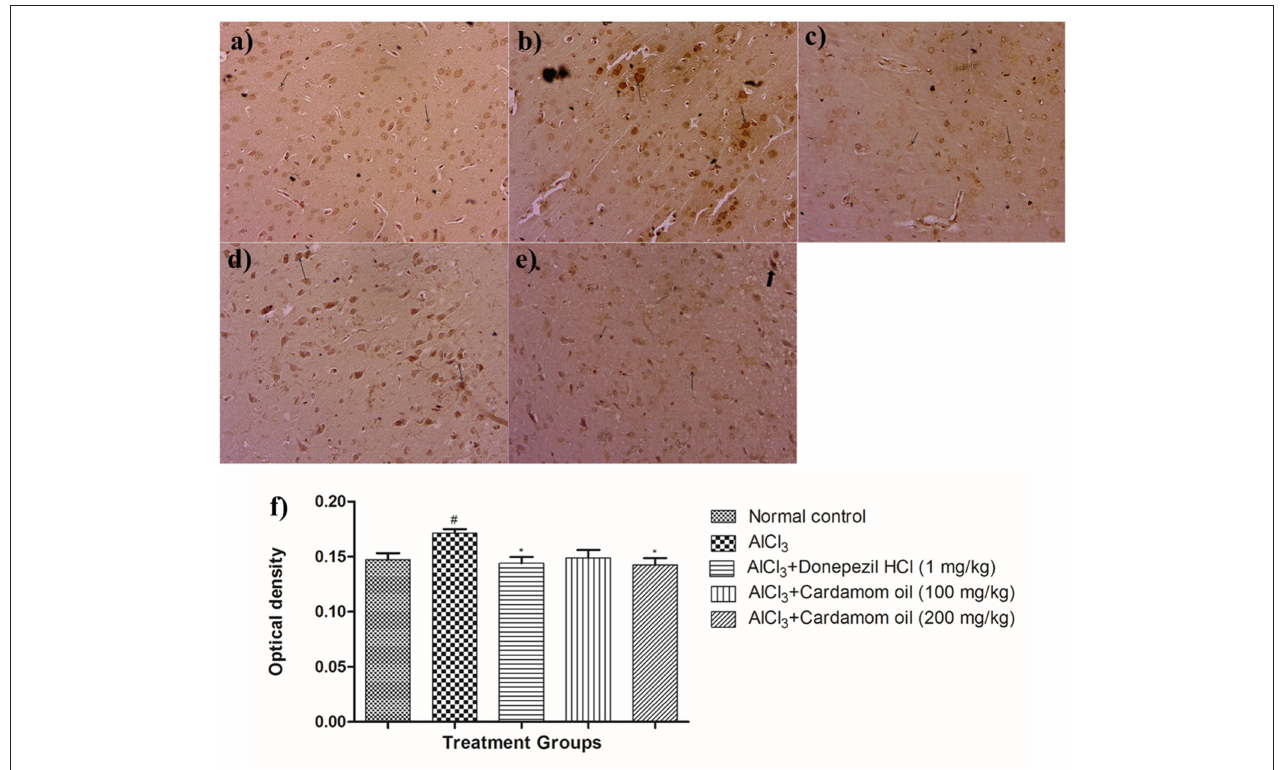
FIGURE 10 | Effect of cardamom oil on amyloid β expression in cortex tissue (400X). (a) Normal control: Cortex: showing normal neuronal cells without immunoreactivity (arrow){Immunostaining: Amyloid- β , 400X}, (b) AlCl 3 group: Cortex: showing significantly enhanced expression of amyloid- β , exhibited by brown coloration at cortical neurons {Immunostaining: Amyloid- β , 400X}, (c) AlCl 3 + Donepezil hydrochloride (1 mg/kg): Cortex: showing normal histology, normal neuronal cells without immunoreactivity (arrow) {Immunostaining: Amyloid- β , 400X}, (d) AlCl 3 + Cardamom oil (100 mg/kg): Cortex: showing normal histology, significantly enhanced expression of amyloid- β , exhibited by brown coloration at cortical neurons (arrow) {Immunostaining: Amyloid- β , 400X}, (e) AlCl 3 + Cardamom oil (200 mg/kg): Cortex: showing normal neuronal cells without immunoreactivity at cortex (small arrow), note weak immunoreactivity (large arrow){Immunostaining: Amyloid- β , 400X}, (f) Histogram of IHC. Data are expressed as mean ± SEM ( n = 6), # p < 0.05 when compared with normal control, * p < 0.05 when compared with disease control group. The magnification was 400 X. AlCl 3 , Aluminum chloride; SEM, Standard Error of Mean; IHC,